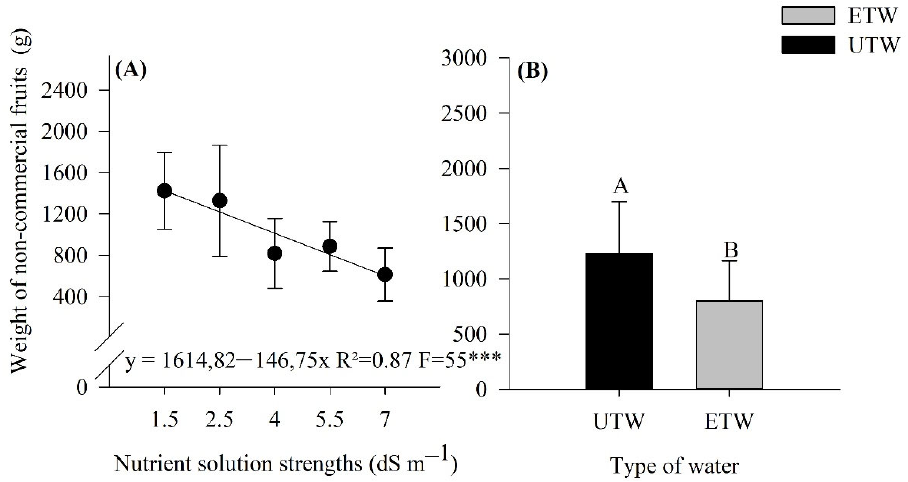
Figure 4. Weight of non-commercial fruits (with apical rot) from the tomato crop submitted to different strenght nutrient solution with electromagnetically treated water (ETW) and untreated water UTW). ( A ) effect only of the different strength nutrient solution, ( B ) effect of the type of water used in irrigation. According to the Tukey test, the means followed by the same letter, lower case comparing the type of water, do not differ statistically ( p < 0.05). The error bars indicate the standard deviation of the average of four repetitions ( n = 4). *** significant at 1%.